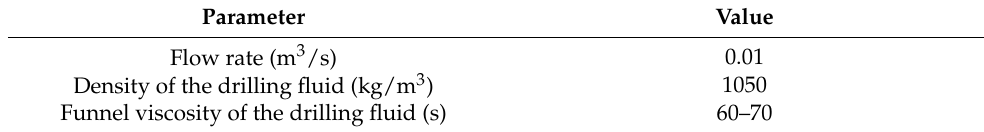
Table 1. Field experimental conditions.